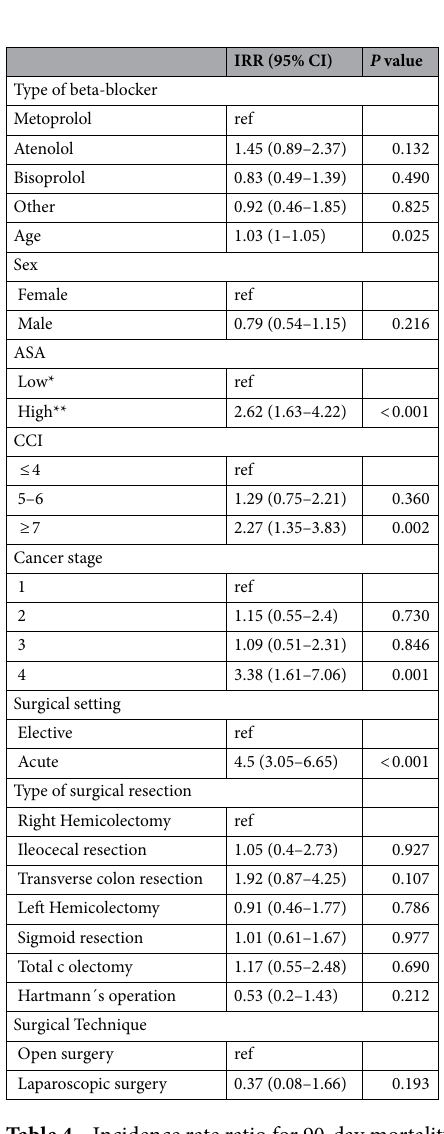
Table 4. Incidence rate ratio for 90-day mortality after colon cancer surgery. *ASA 1–2. **ASA 3–5. Poisson regression model with robust standard errors. Model adjusted for age, sex, ASA, CCI cancer stage, surgical setting, type of surgery, and operation method. IRR, Incidence rate ratio; ASA, American Society of Anesthesiologists; CCI, Charlson comorbidity